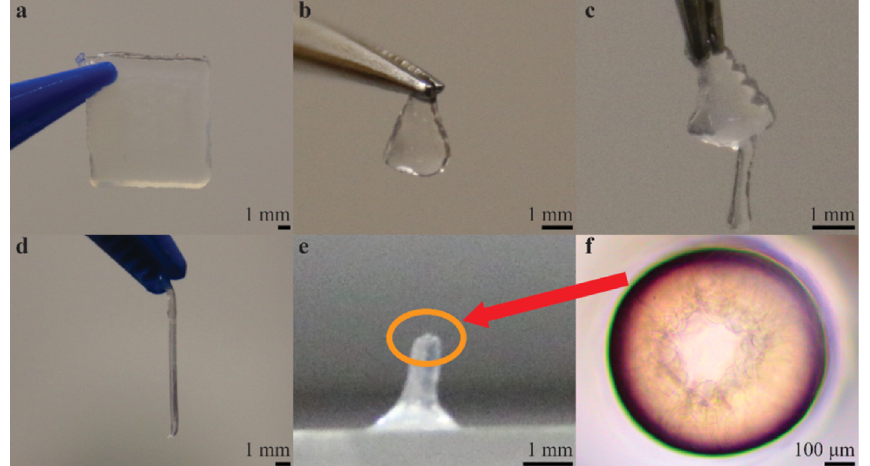
Figure 2. Different structures of microreactive inkjet-printed alginate hydrogels. ( a ) Alginate rectan- gular film ( f = 500 Hz, 10 layers). ( b ) Alginate triangular film ( f = 100 Hz, 20 layers). ( c ) Alginate tree ( f = 100 Hz, 20 layers). ( d ) Alginate stick ( f = 100 Hz, 200 layers). ( e ) Alginate hollow tube ( f = 10 Hz, 300 layers). ( f ) Microscopic image of the hollow tube. Reproduced with permission from [77], American Chemical Society, 2020.